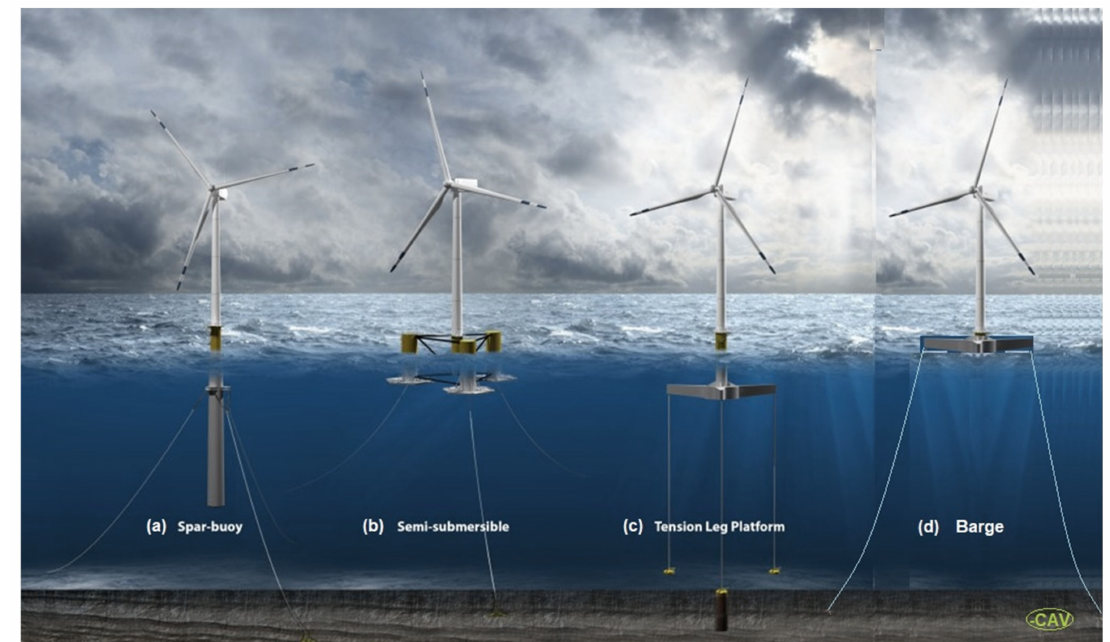
Figure 9. Different types of offshore wind turbines, showing ( a ) the spar-buoy, ( b ) the tension leg platform, ( c ) the semi-submersible and ( d ) the Pontoon-type (Barge-type) floating wind turbines (Original Illustration by Josh Bauer of NREL, Courtesy: NREL and DNV; Image adapted with permission from NREL and DNV, by Author